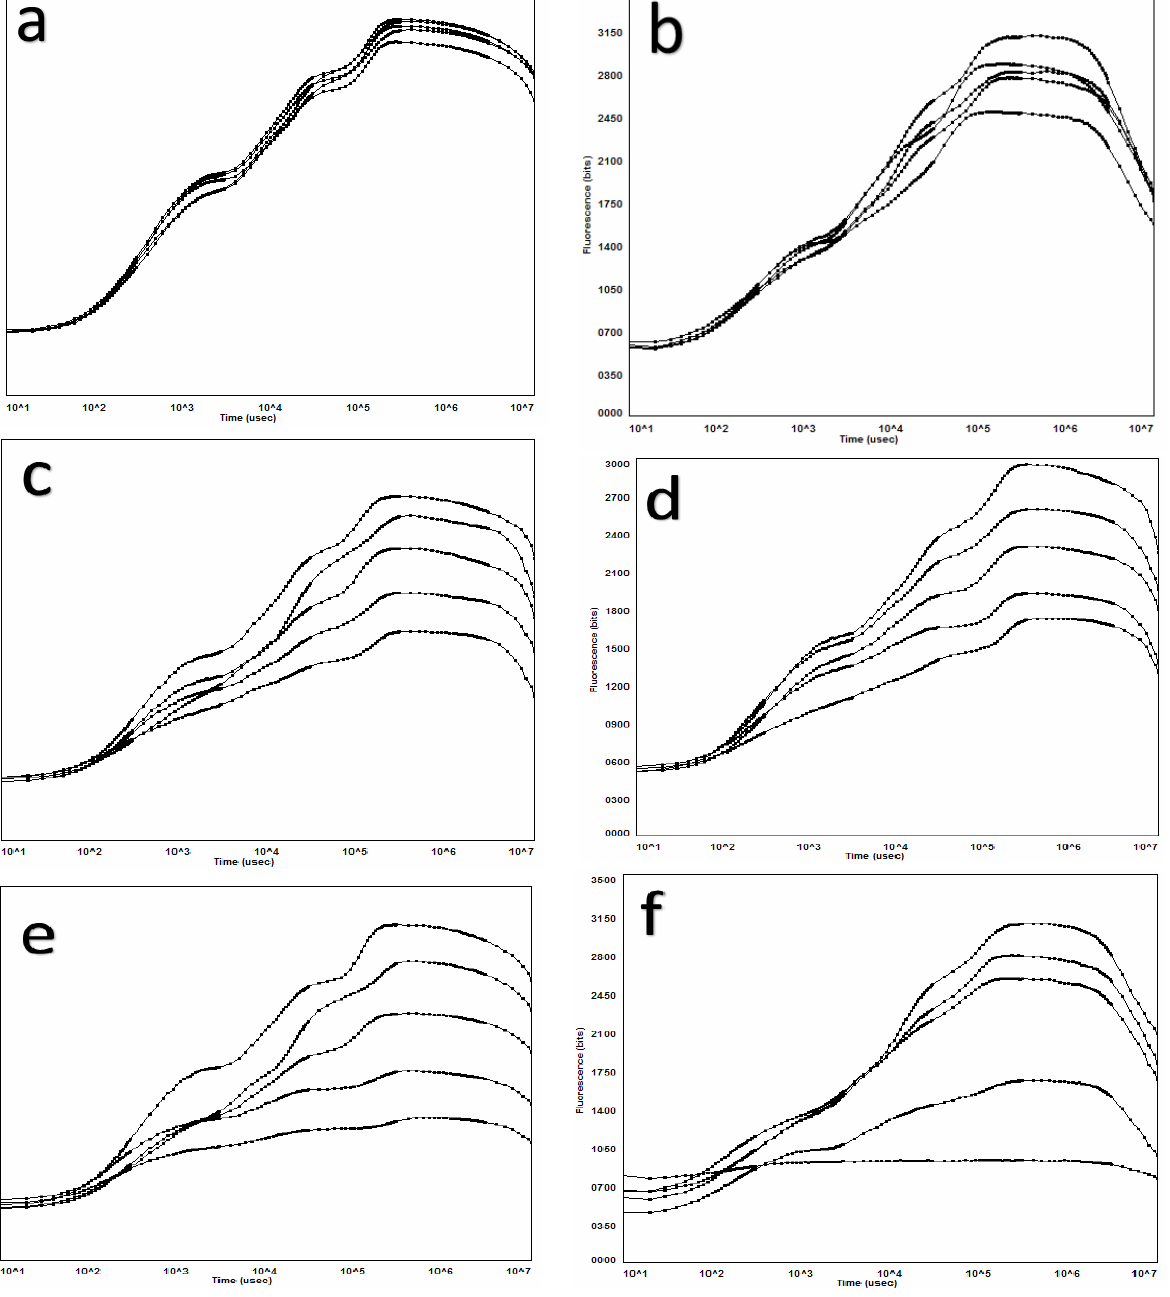
Fig. 2. Effect of sethoxydim only on the shape of the katusky curve in wild oat at 1, 2, 3, 5 and 7 days after treatment: a; 0, b; 45, c; 94, d; 187, e; 281 and f; 375 gr a.i.